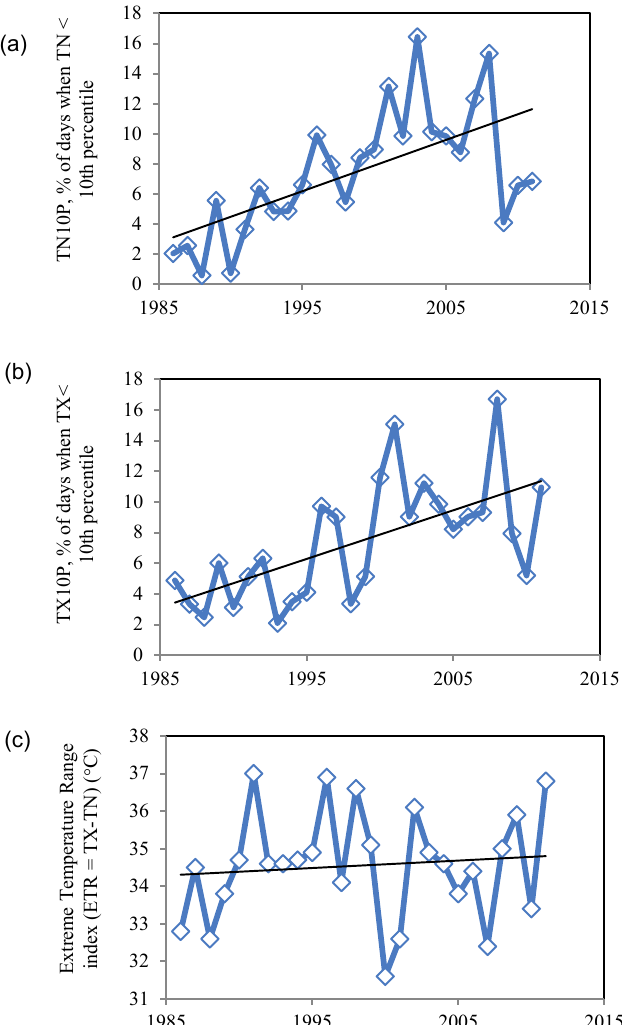
Fig. 3 Trends of different temperature indices relative to the base period 1986–2000: (a) cold nights, (b) cold days (c) Extreme Temperature Range